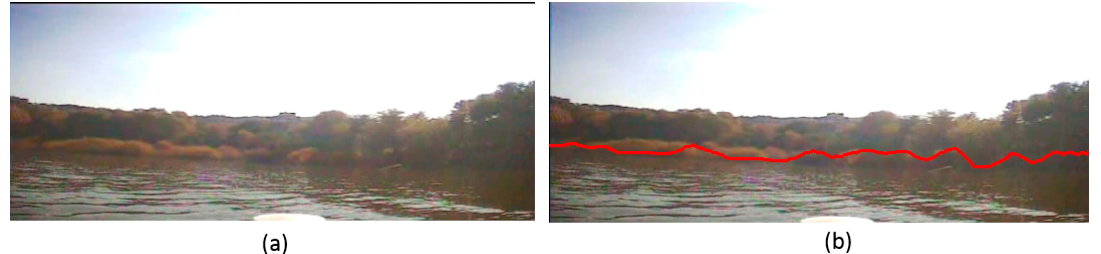
Figure 23. Waterline detection result when illumination is bad. ( a ) The image before our detection; ( b ) The image after our detection.